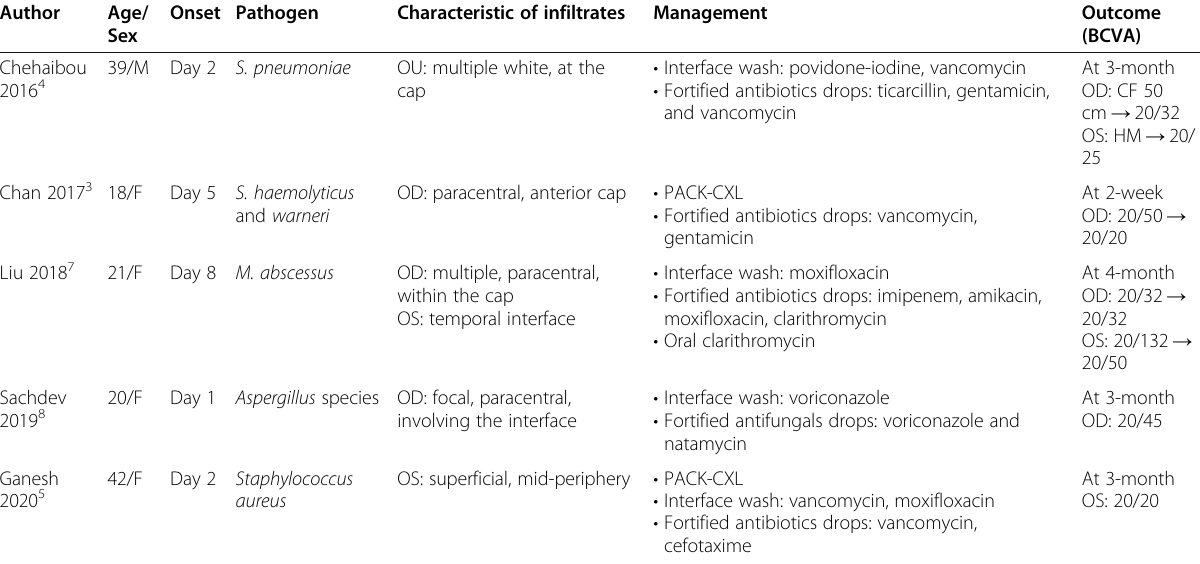
Table 1 Previous case reports of post-SMILE infectious keratitis